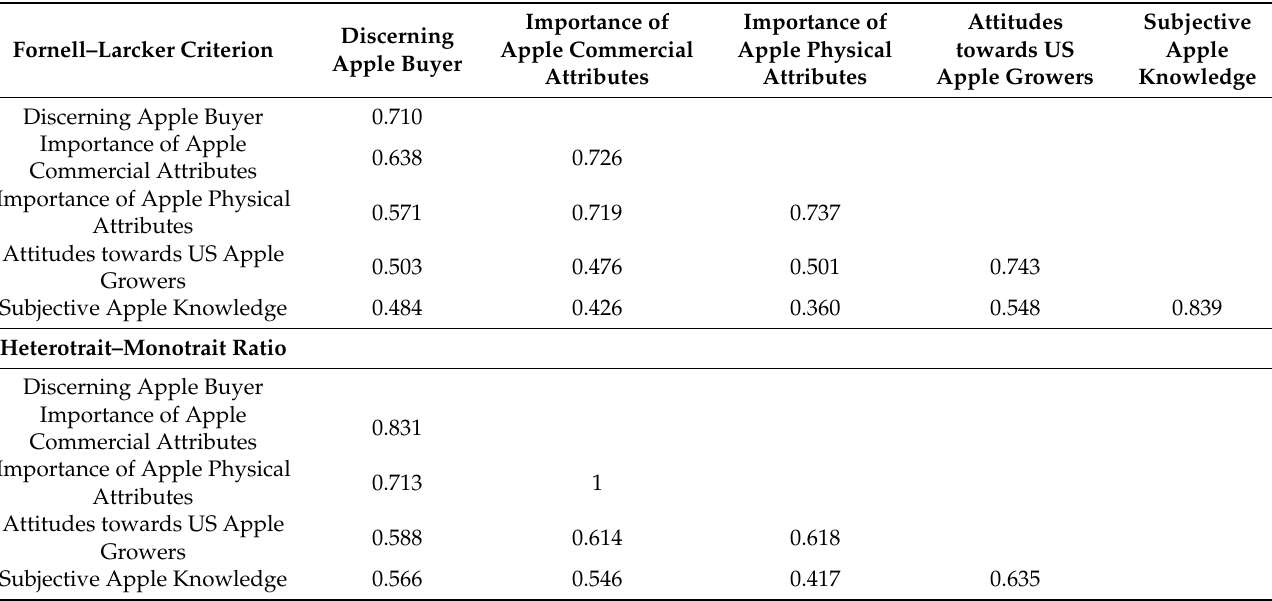
Table 3. Scale discriminant validity.